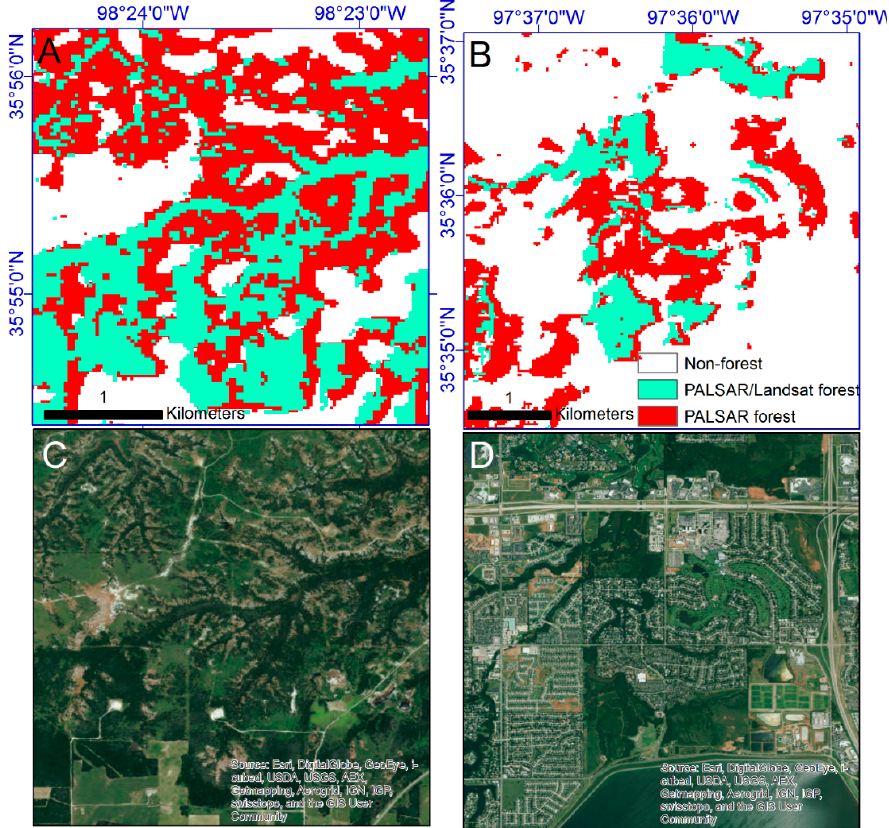
Figure 13. Spatial comparison of the PALSAR forest map and the PALSAR/Landsat forest map in two zoom-in windows ( A , B ) in 2010; ( C , D ) are high spatial resolution images in two zoom-in windows circa 2010.